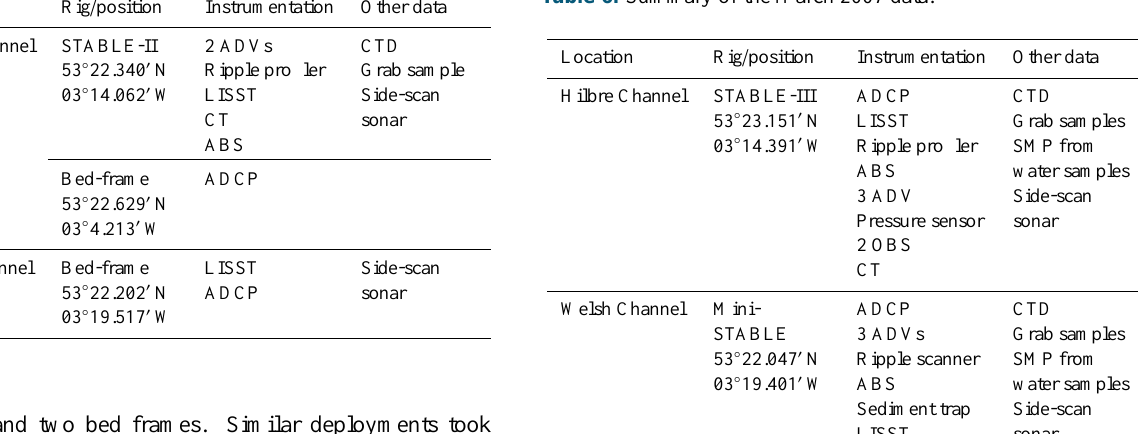
Table 6. Summary of the March 2007